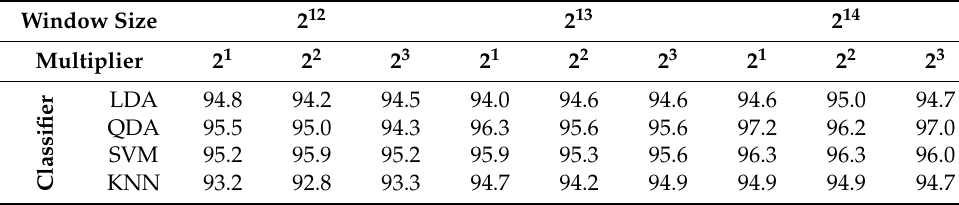
Table 1. Group prediction accuracy (%) of different classification